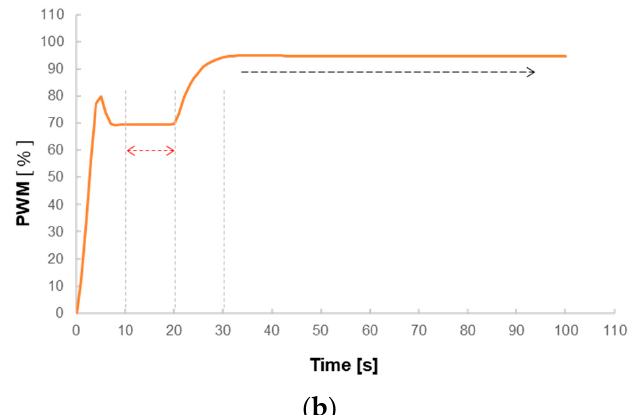
Figure 10. When the PID parameter is set K p = 0.05, K i = 0.1, K d = 0, ( a ) The sensed pressure change, and ( b ) The change in PID modulating PWM output, before and after pressing down the micro spray gun.